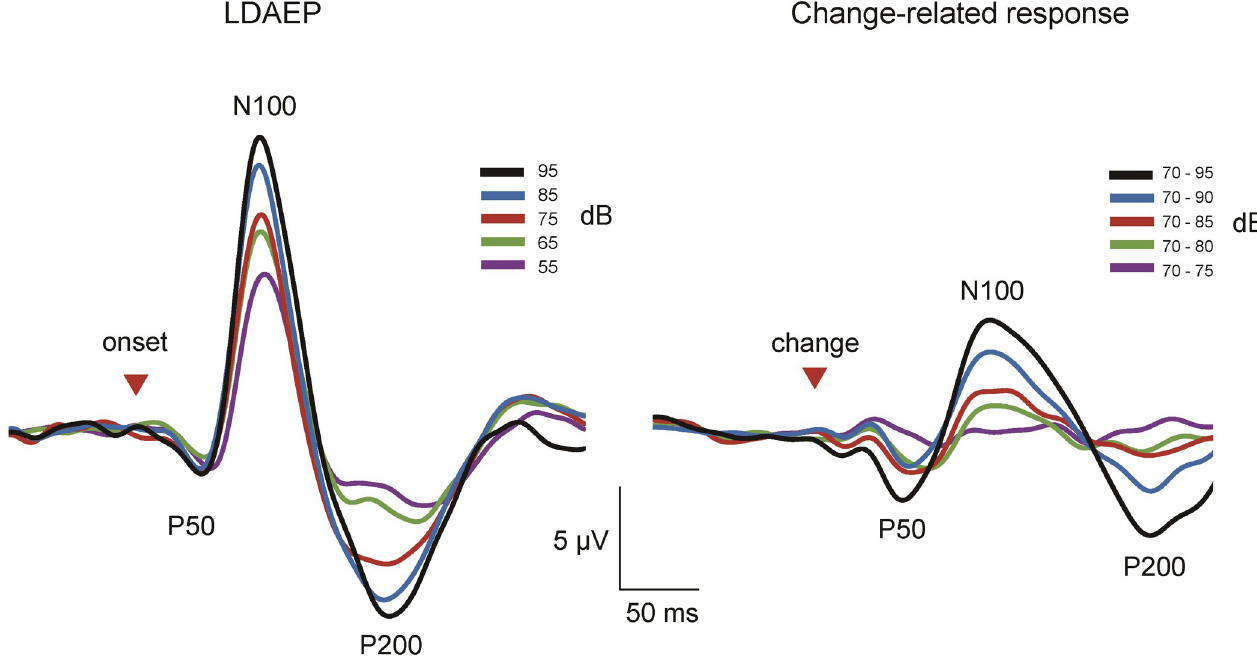
Fig 2. Grand-averaged waveforms of the onset and change-related responses. Grand-averaged waveforms of the onset responses (A) and change-related responses (B) for each condition. Red arrowheads indicate the sound (A) and change (B) onsets.